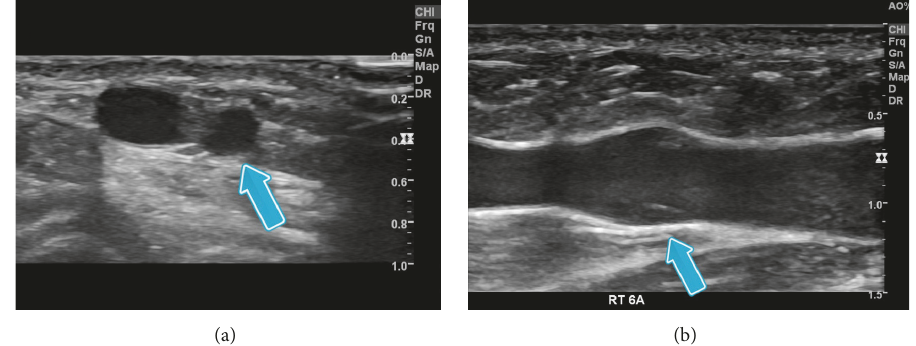
Figure 3: (a) Ultrasound image of branching vein (arrow) joining studied vein and (b) ultrasound image of valve showing two linear and symmetrical valve leaflets in dilated vein sinus